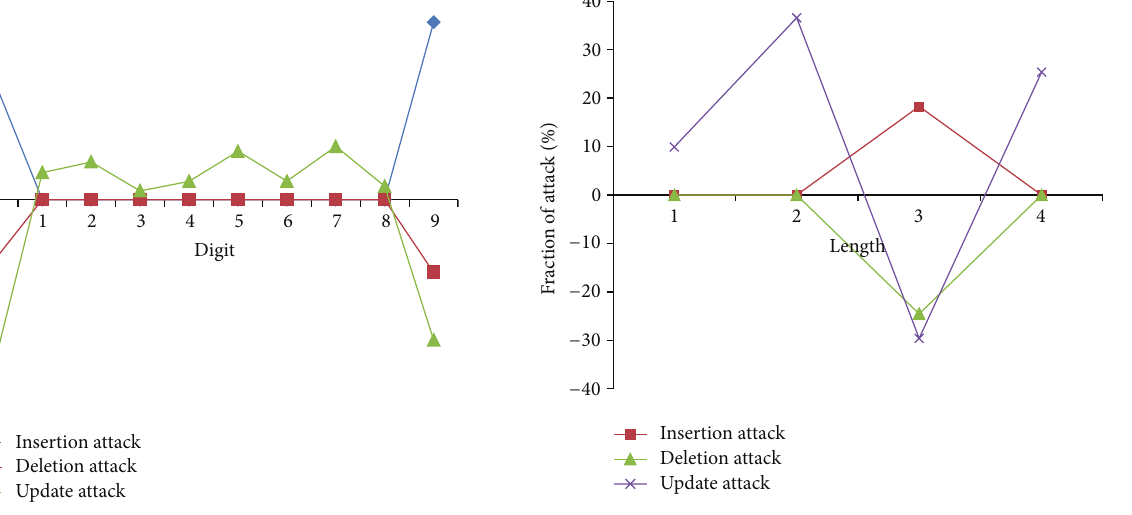
Figure 4: Characterization of malicious insertion, deletion, and update attacks on digits 9 and 0 of data values.